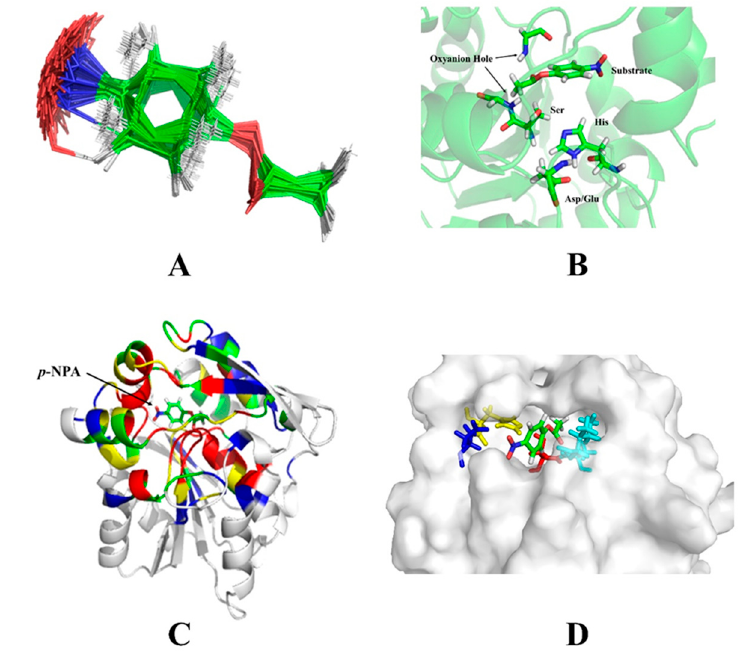
Figure 4. The output of the Rosetta design. ( A ) Superimposition of substrate rotamers. The single bonds in the p-nitrophenyl acetate (p-NPA) substrate were rotated to form various rotational isomers to fit in the active sites of different shapes. The rotating isomers were stacked at the carbonyl carbon to form a set of conformational isomers. ( B ) The initial output structure of RosettaMatch. The catalytic residues, oxyanion and substrate are shown as stick models. The rest of the structure is shown as ribbons. ( C ) The residues in proximity to the substrate. The residues close to the substrate are marked in different colors according to their distances to the substrate. ( D ) The output of RosettaDesign. The substrate is shown in stick models and the designed esterase is shown in the surface model. The substrate fits well in the active site.